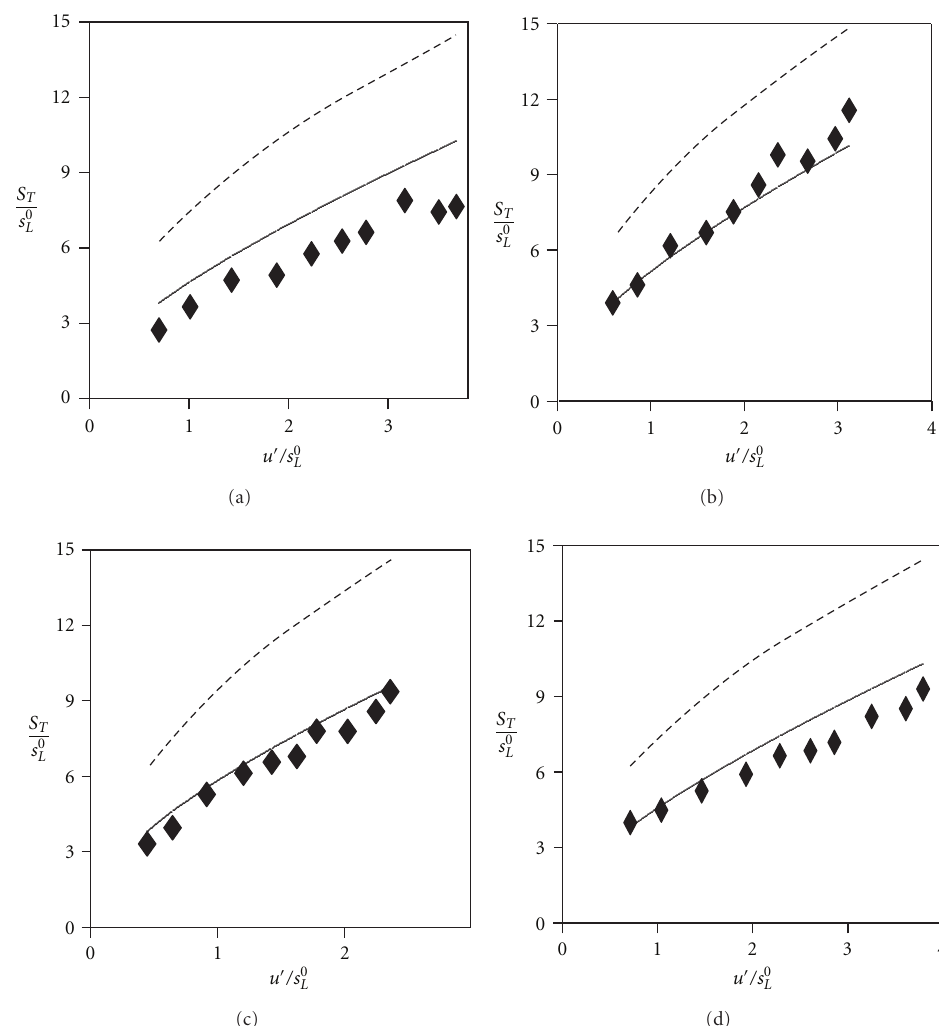
Figure 2: The predictions of turbulent flame speed expressions, (6) (solid line) and (8) (dashed line), are compared to the experimental data of [31] for various equivalence ratios: (a) φ = 0 . 8; (b) 1.0; (c) 1.2; (d) 1.4.